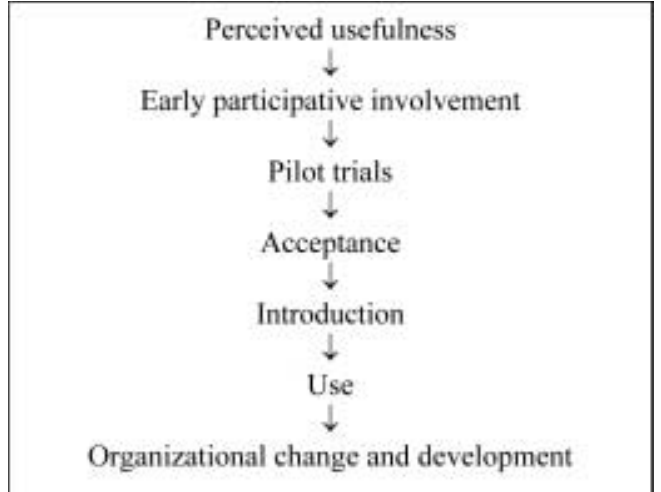
Figure 1. Process model of the introduction of new